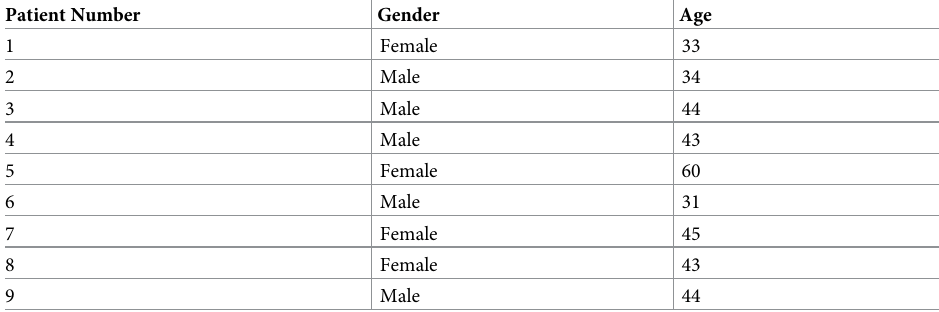
Table 2. Characteristics of the enrolled patients who completed the in-depth